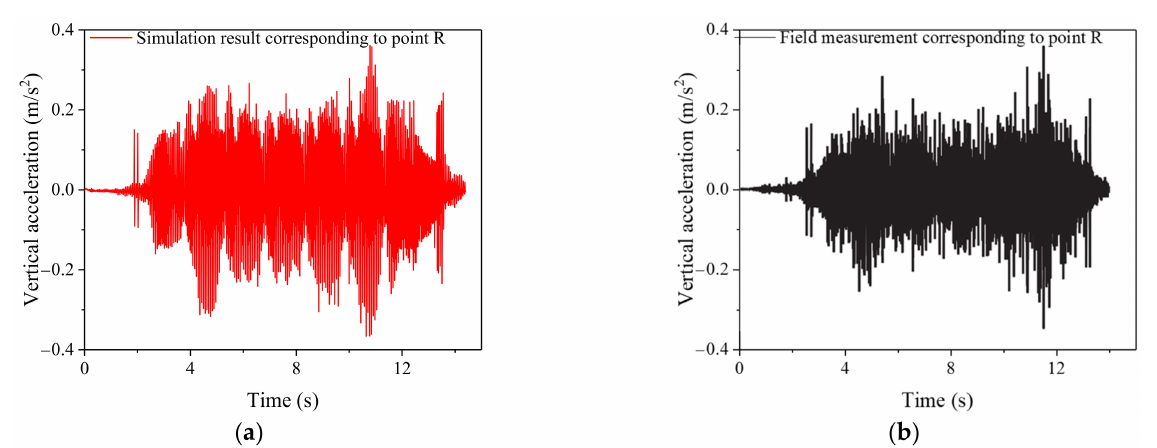
Figure 12. Vertical acceleration at point R. ( a ) Vertical acceleration from numerical model; ( b ) vertical acceleration from field test measurement Reprinted from Ref. [43]. 2019, Zhou Shunhua.